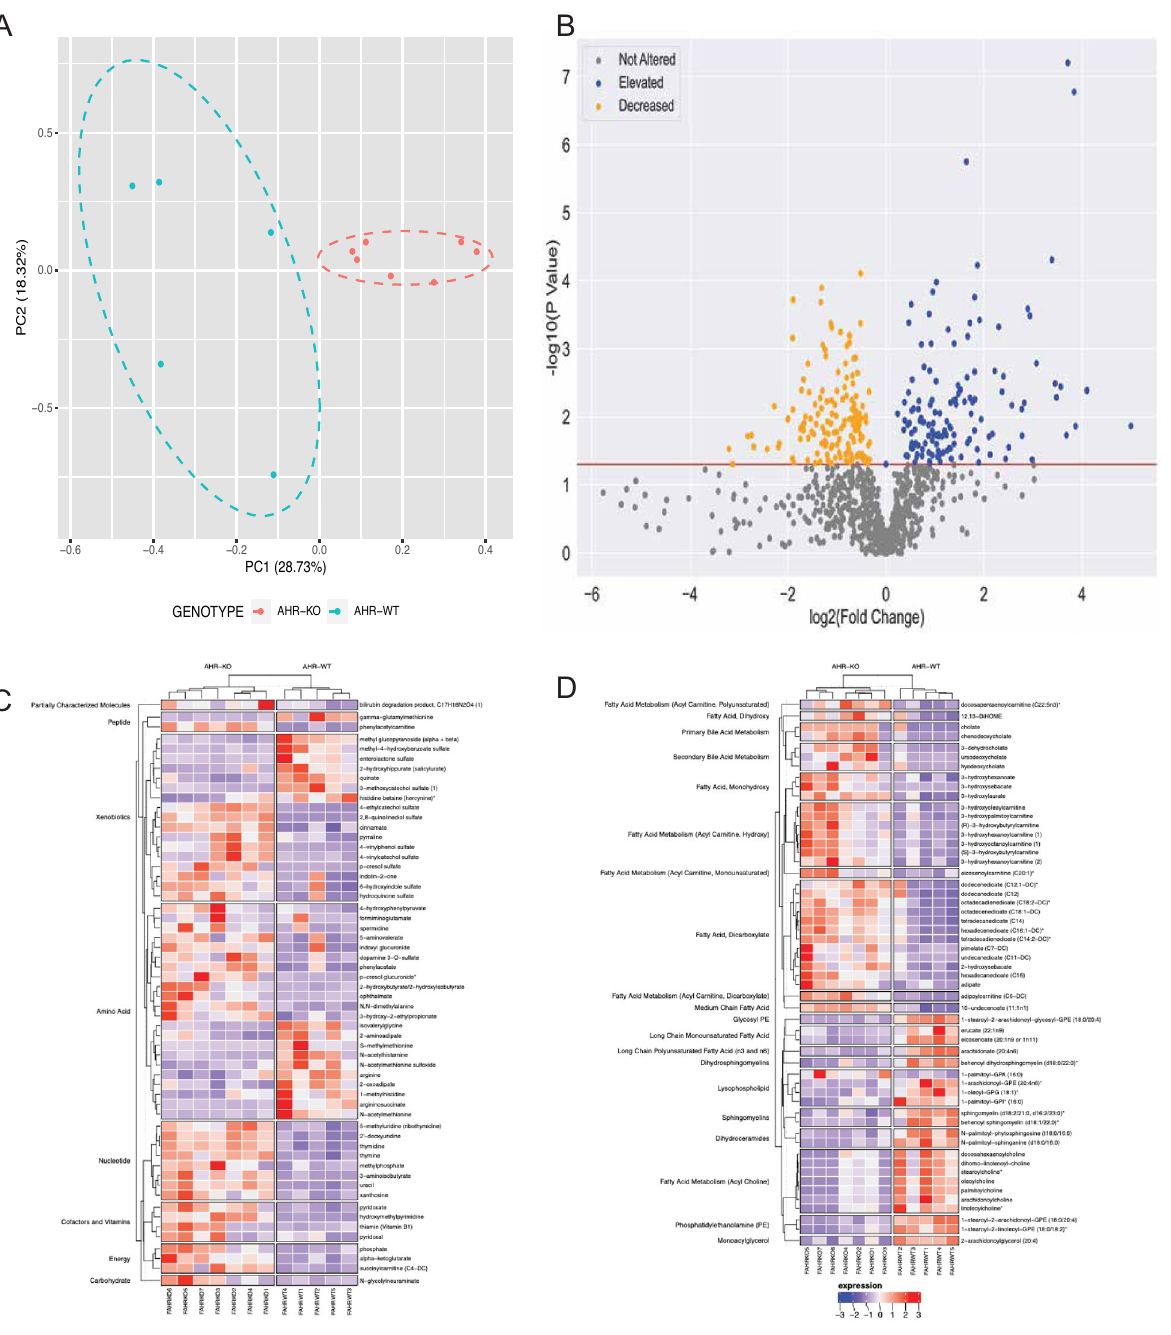
Figure 1. Loss of Ahr has a major impact on the serum metabolome of mice. ( A ) Principal component analysis reveals separation between the Ahr −/− and Ahr +/+ mice. ( B ) Of the 965 surveyed metabolites, 290 were significantly altered ( p < 0.05), with 138 elevated and 152 decreased. ( C ) Heatmap of the most significantly altered non-lipids (Partially Characterized Molecules, Peptides, Xenobiotics, Amino Acids, Nucleotides, Cofactors and Vitamins, Energy, and Carbohydrate superpathways) show the differences between Ahr −/− (n = 7) and Ahr +/+ (n = 5). ( D ) The Lipid superpathway, the largest measured superpathway, also has several altered metabolites. Heatmaps were generated using the ComplexHeatmap in R software